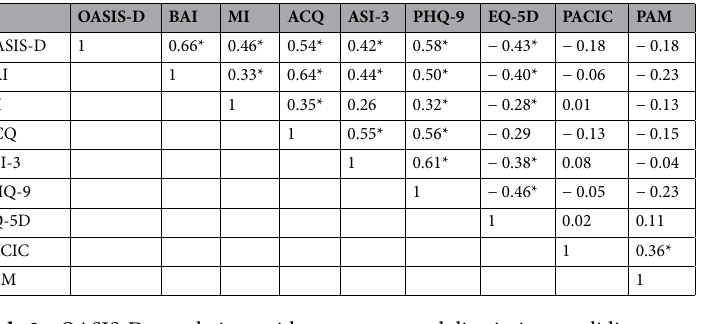
Table 2. OASIS-D correlations with convergent and discriminant validity measures. ACQ Anxiety Cognitions Questionnaire, ASI‑3 Anxiety Sensitivity Index-3, BAI Beck Anxiety Inventory, EQ‑5D EuroQoL questionnaire